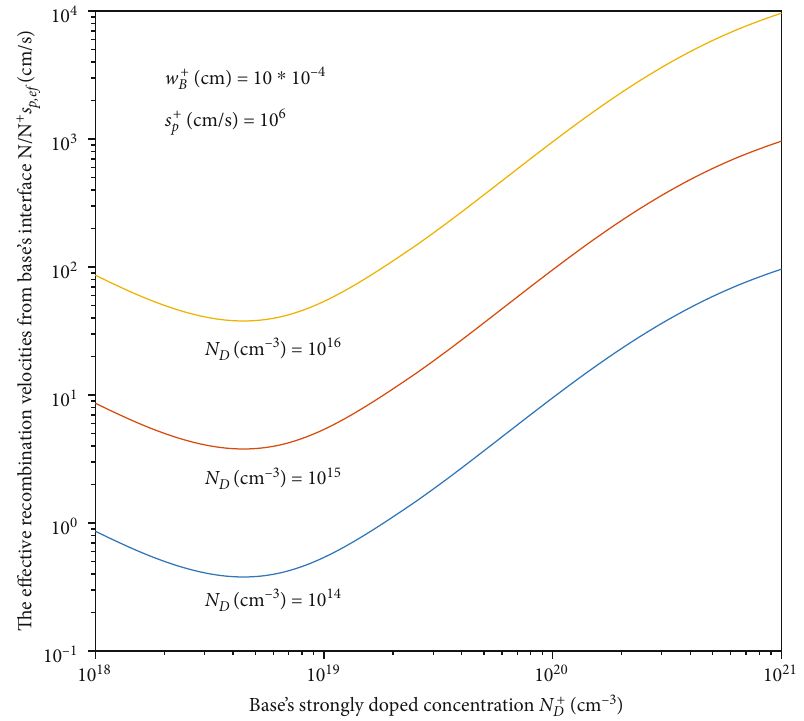
Figure 14: The e ff ective recombination velocities from base ’ s interface N/N + s the case of w B + = 10 × 10 − 4 cm and s p + = 10 6 cm/s .